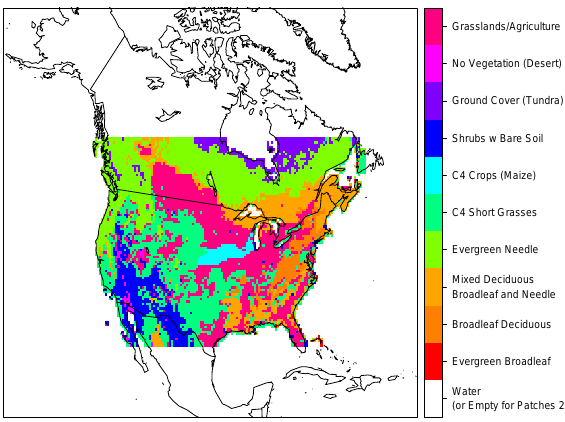
Fig. 1. Dominant SiB3 biome classes for the first biome patch de- rived from MODIS 12 Landcover